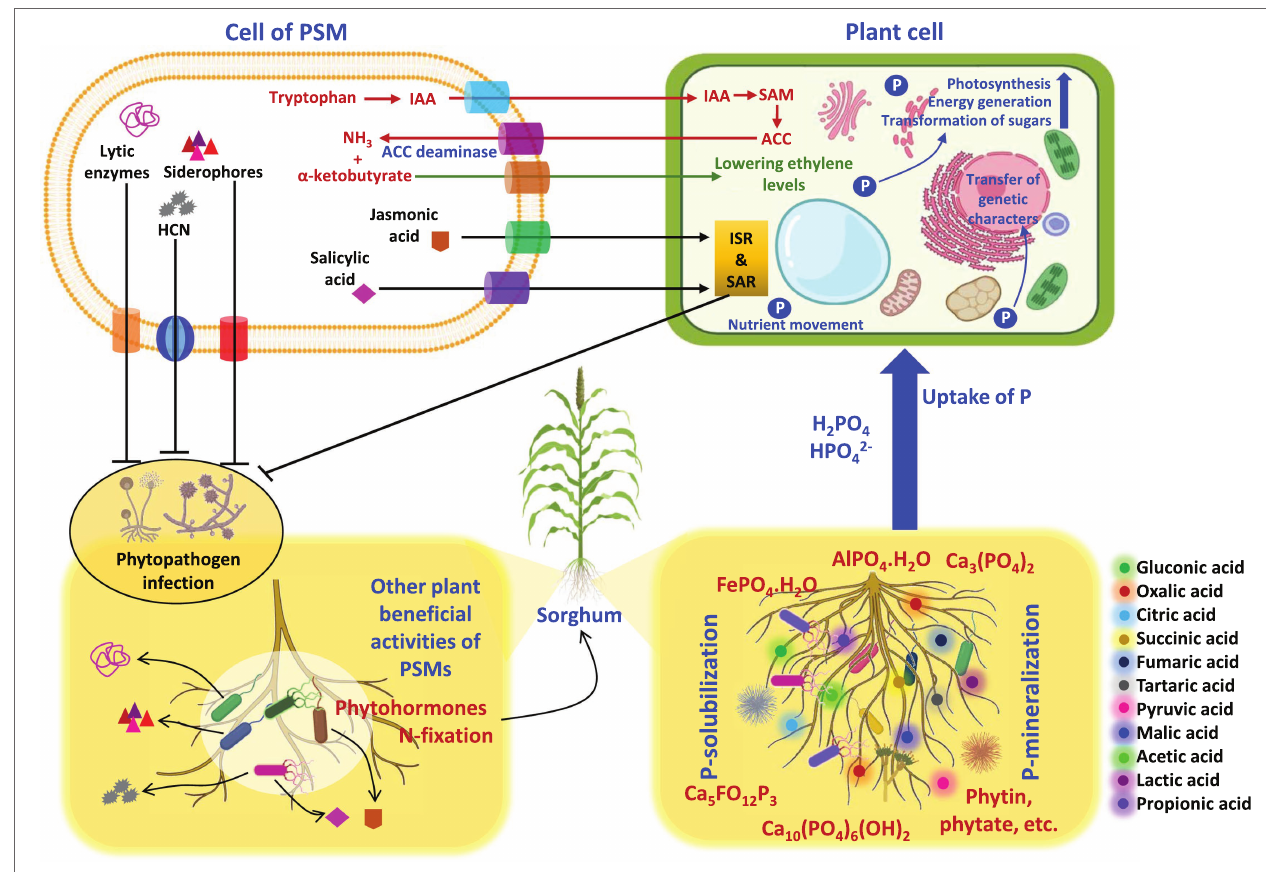
FIGURE 3 | Interactions of PSM with sorghum plants at cellular levels enhancing the growth of sorghum. HCN, hydrogen cyanide; IAA, indole-3-acetic acid; ACC, 1-aminocyclopropane-1-carboxylic acid; SAM, S-adenosyl methionine; ISR, induce systemic resistance; SAR, systemic acquired